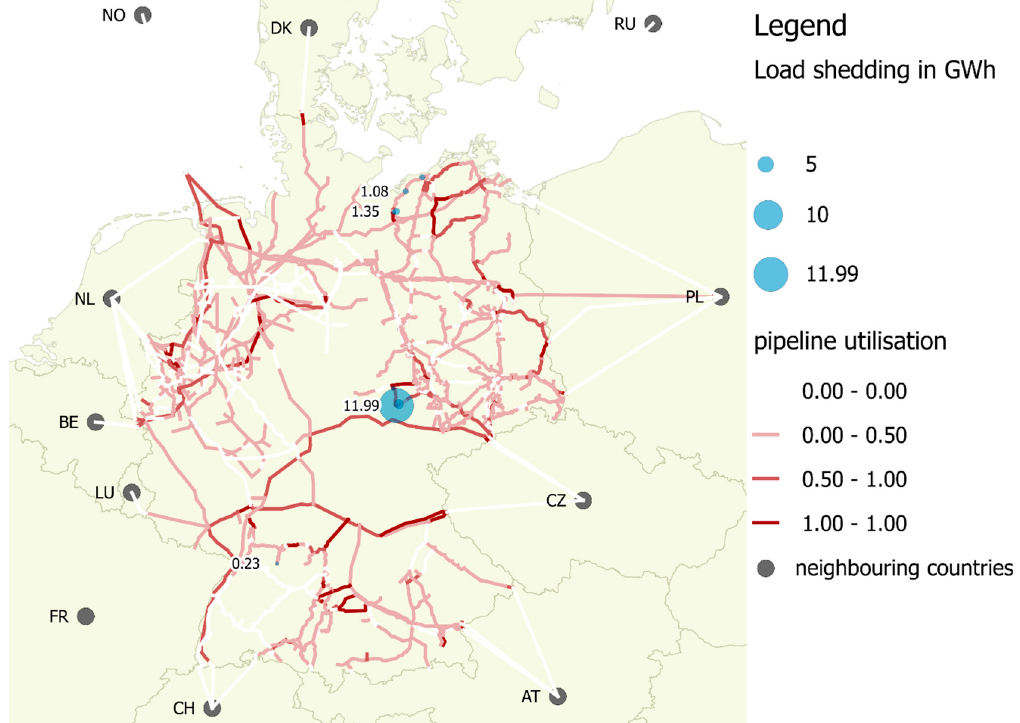
Figure 15. Results of GAMAMOD-DE for pipeline utilization on the 6 th of February 2030.